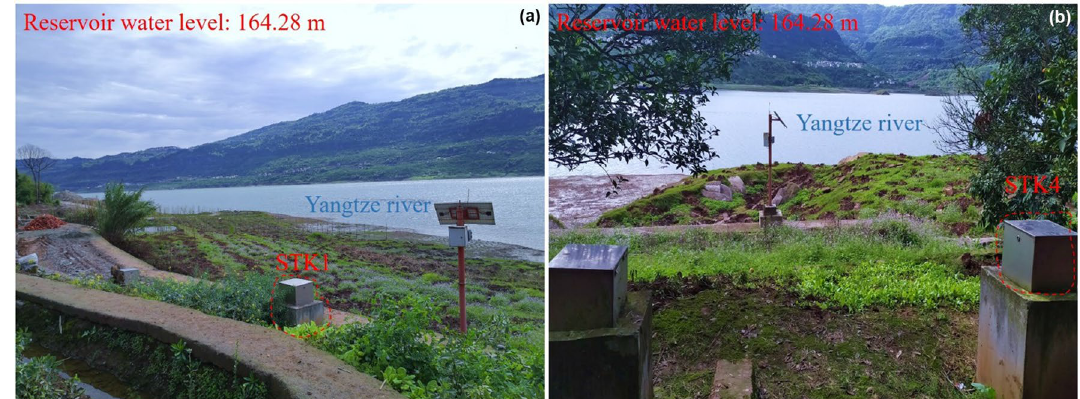
Figure 6. Hydrological monitoring hole of 175 m water level. ( a ) The STK1 monitoring hole; ( b ) the STK4 monitoring